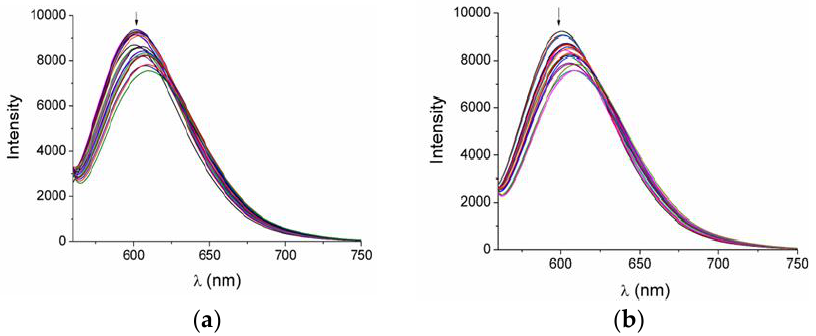
Figure 7. Fluorescence emission spectra ( λ ex = 540 nm) for EB –DNA ([EB] = 20 μM, [DNA] = 25 μM) in buffer solution upon addition of increasing amounts of compounds 3 ( a ) and 4 ( b ) The arrows show the changes in the emission intensity upon increasing amounts of the two compounds. Table 4. Percentage of EB – DNA fluorescence quenching ( Δ I/Io, in %), EB-DNA Stern – Volmer con-